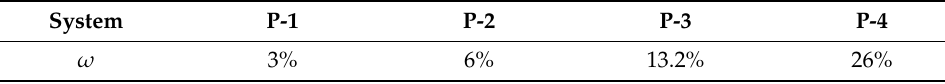
Table 1. Proportion of NaCl in the